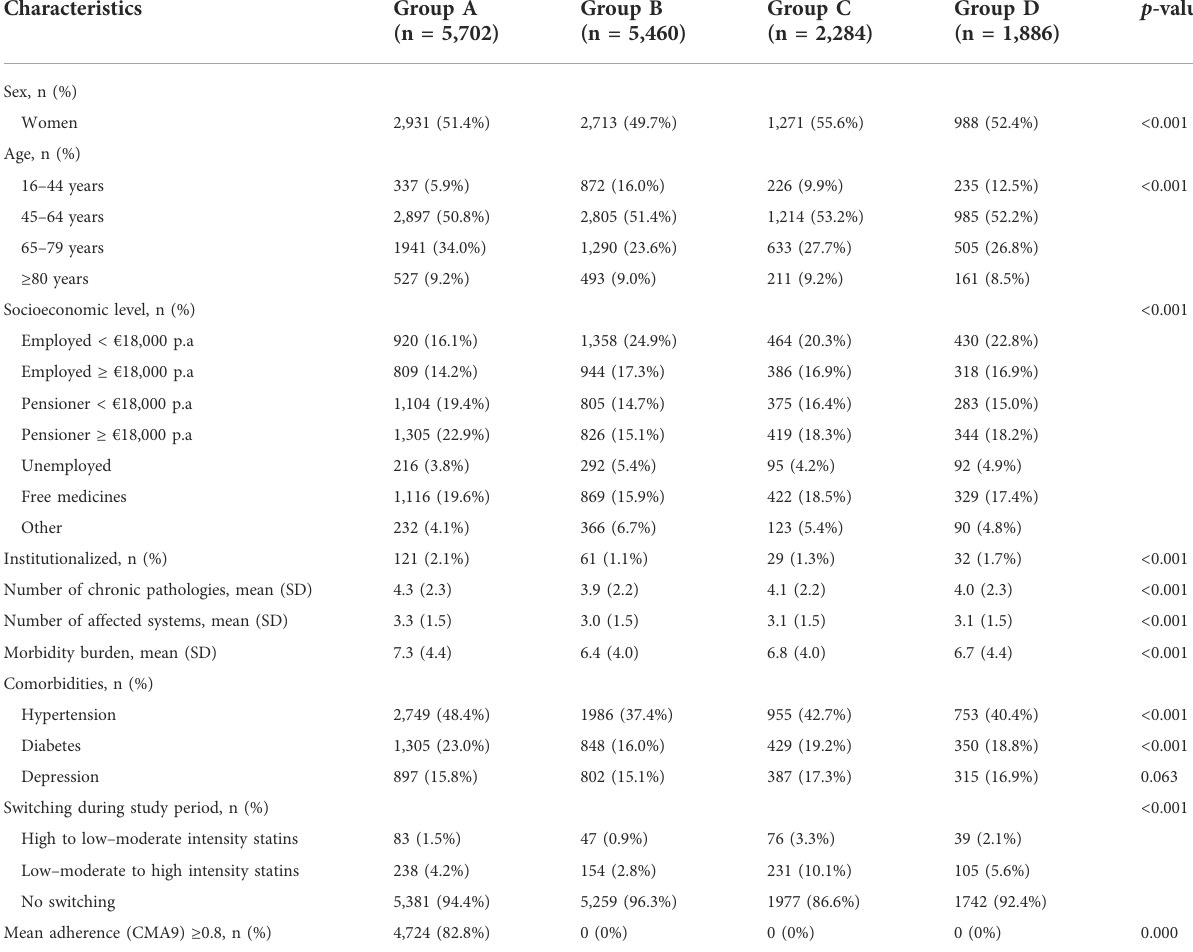
TABLE 2 Comparison of characteristics of statin users in each group.